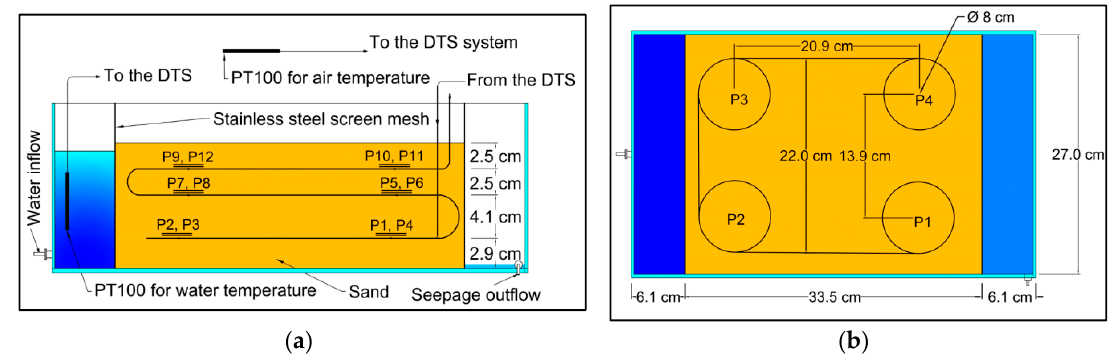
Figure 2. Geometry of the experimental model. ( a ) Side view of the model; ( b ) top view of the model at the elevation of 2.9 cm.